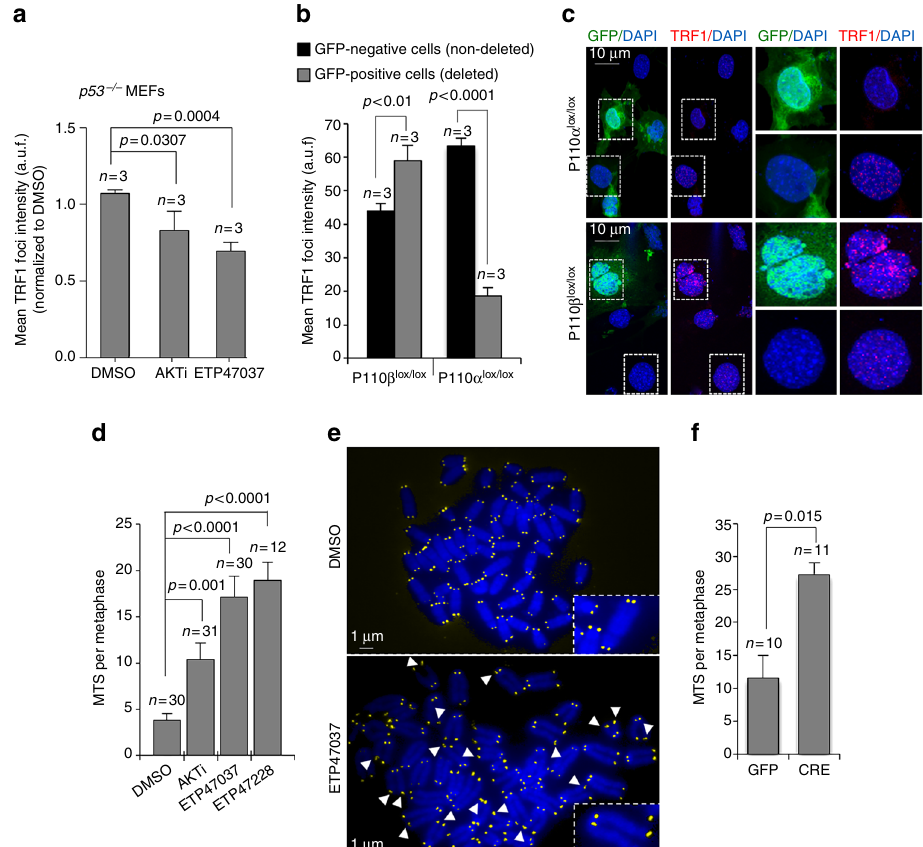
Fig. 3 TRF1 telomeric levels are regulated by p110 α . a Quanti fi cation of mean TRF1 foci intensity by immuno fl uorescence of immortalized p53 − / − MEFs were treated either with DMSO, AKT inhibitor (AKTi), or with ETP47037. b Quanti fi cation of mean TRF1 foci intensity by immuno fl uorescence in p110 α (lox/lox) and p110 β (lox/lox) MEFs infected with Adeno-CRE-GFP. The graph shows quanti fi cation of TRF1 foci in both infected (Ad-CRE-GFP) and non- infected (negative) cells. c Representative TRF1 (red) and GFP (green) immuno fl uorescence images. Scale bars are shown. d Incidence of multitelomeric signals (MTS) events in metaphase spreads of lung cancer-derived cells (CHA 9-3) treated either with DMSO, AKT inhibitor (AKTi) (10 μ M), ETP47037 (10 μ M), or ETP47228 (10 μ M). e Representative images of metaphase spread corresponding to DMSO- and to ETP47037-treated cells. MTS are labeled with a white arrow head. Zoomed images are shown in the insets. Scale bars are shown. f Incidence of multitelomeric signals (MTS) events in metaphase spreads of immortalized P110 α lox/lox MEFs either transduced with GFP or with Cre recombinase. ( n ) Analyzed metaphases in each condition. The Student ’ s t test was used for statistical analysis; P values are shown. Error bars represent standard deviation. n number of independent